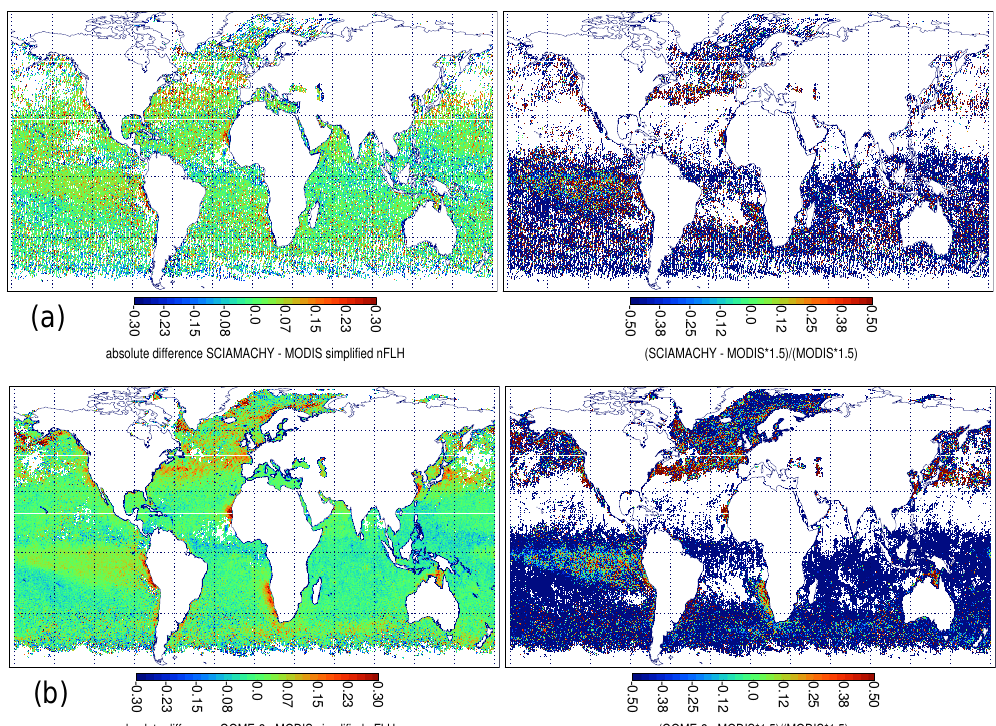
Figure 15. Monthly mean (simplified) normalized fluorescence line height (nFLH) differences between SCIAMACHY and MODIS (a) , and GOME-2 and MODIS (b) for May 2007 in terms of absolute difference (left) and fractional difference with respect to MODIS (right) for grid boxes where MODIS nFLH > 0.05. MODIS values on the right have been scaled up by 1.5 to produce fractional differences near 0 in the Pacific low latitudes in (b) below to show that differences are not a simple scale